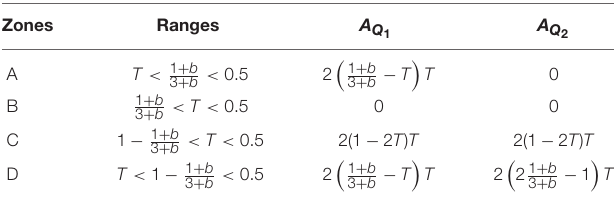
TABLE 4 | Areas of the basin of attraction of chimera states in the parameter space of initial conditions of x aa and x bb according to the zones described in Figure 2